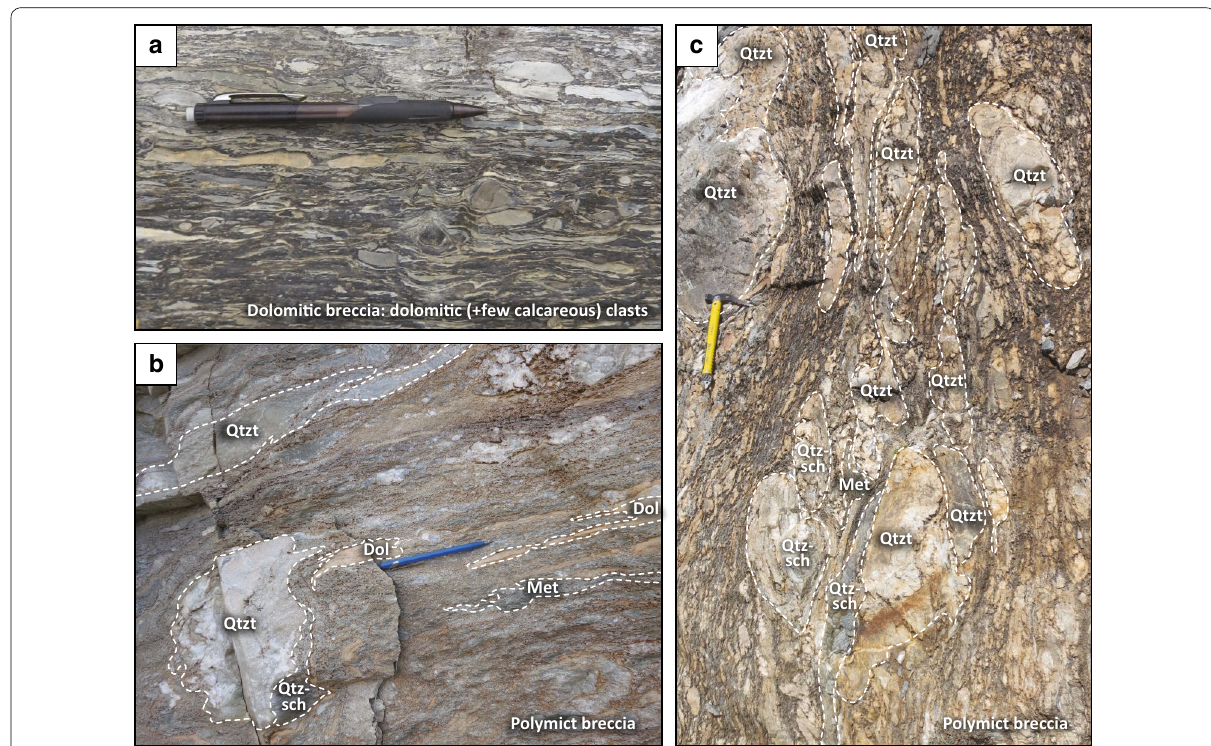
Fig. 5 Typical facies of the Evolène Series breccias. a Matrix‑supported dolomitic breccia: clasts are mainly dolomitic; matrix is dark and calcarenitic [599 ′ 460/267 ′ 340]. b Clast‑supported polymict breccia [595 ′ 370/101 ′ 930]. Main clasts lithologies: pure quartzite ( Qtzt ), quartzschists ( Qtz-sch ), metabasites ( Met ) identical to those of the Métailler Fm. (Mont Fort basement), dolomites ( Dol ). c Clast‑supported coarse polymict breccia. Block fallen from the Pointe du Vasevay southern face [593 ′ 810/097 ′